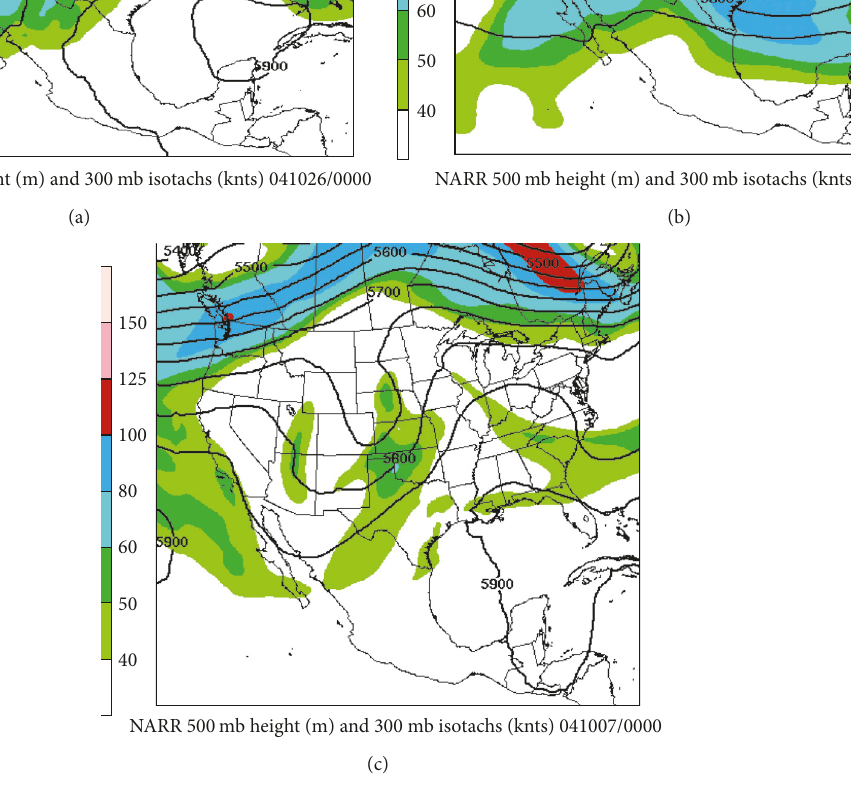
ON and dust multiplied 10 times (a1d10), (e) dust allowed to act only as CCN (a1dccn), and (f) dust allowed to act only as IN